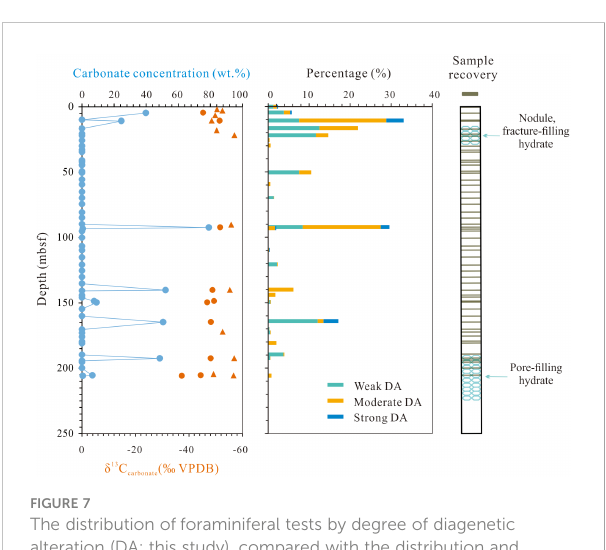
FIGURE 7 The distribution of foraminiferal tests by degree of diagenetic alteration (DA; this study), compared with the distribution and carbon isotope of carbonate nodules (Zhao et al., 2018) at Site